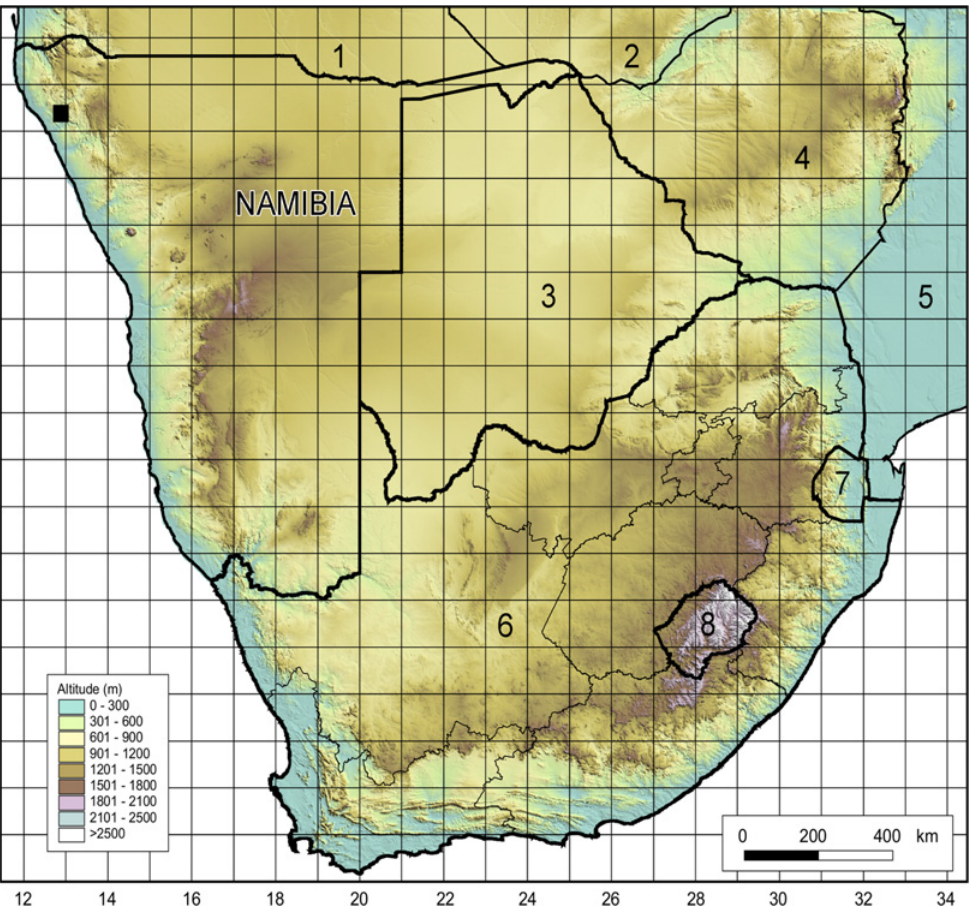
Fig 2. Geographical distribution of Oberholzeria etendekaensis . Topographic map of southern Africa showing the known distribution of O . etendekaensis (black square) in the far north-western corner of Namibia. The locality falls within the Kaokoveld Centre of Endemism, a biogeographical region rich in restricted-range plants and animals. The new species is known from a single population comprising two small subpopulations growing about 500 m apart in the Etendeka Mountains. These mountains form part of the Great Escarpment of southern Africa. Neighbouring countries indicated by numbers, namely Angola (1), Zambia (2), Botswana (3), Zimbabwe (4), Mozambique (5), South Africa (6), Swaziland (7) and Lesotho